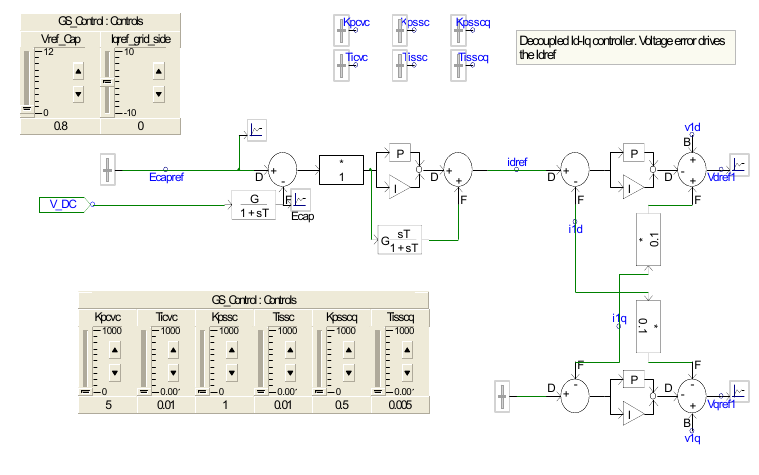
Figure A4. DC voltage control.